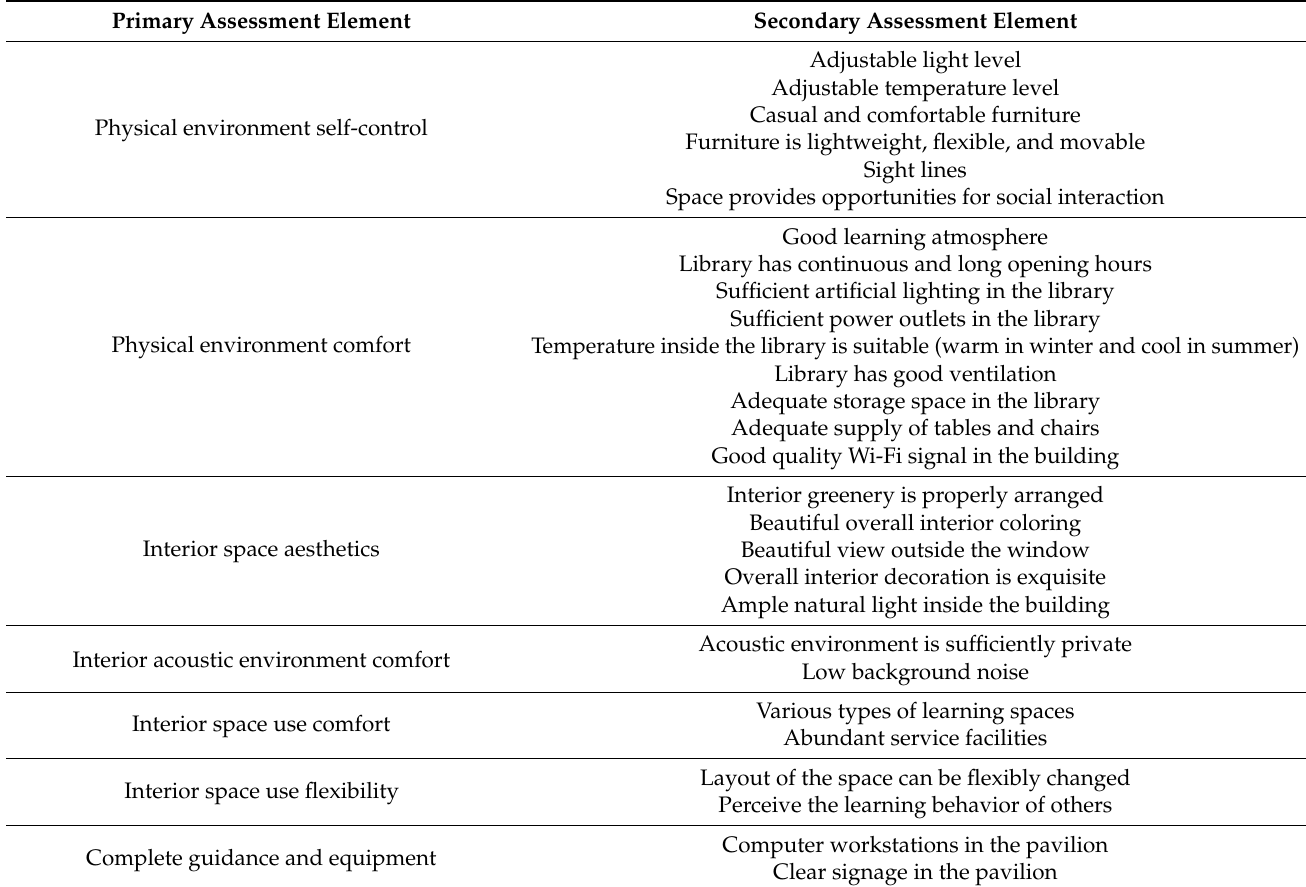
Table 13. Spatial factors that influence the university library space user experience.